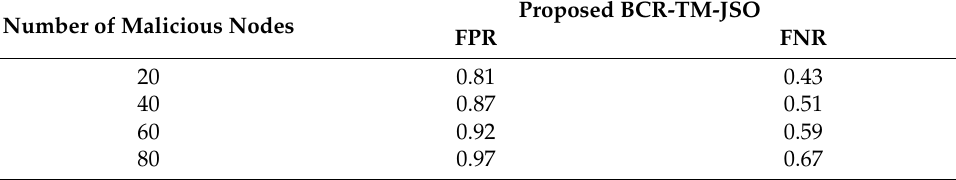
Table 5. Performances of network lifetime in terms of dead nodes.